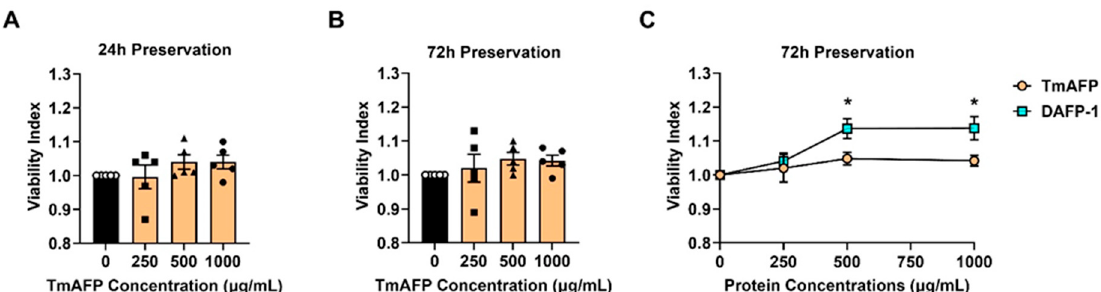
Figure 4. Potency of DAFP-1 in maintaining cold-preserved INS-1 cell viability compared to TmAFP and BSA. The viability index of the cold-preserved INS-1 cells in UW solution supplemented with TmAFP at a different concentration (0, 250, 500, and 1000 µg/mL) for ( A ) 24 h and ( B ) 72 h. The cell viability of each protein condition was normalized by the viability of the UW solution group (AFP 0 µg/mL, open circle) at each time point (solid square, solid triangle, and solid circle for 250, 500, and 1000 µg/mL DAFP-1, respectively). ( C ) The dose-dependent changes of viability indexes for TmAFP and DAFP-1 at 72 h. The data show the mean ± standard error of five to six independent experiments, * p < 0.05 by the Student t -test.